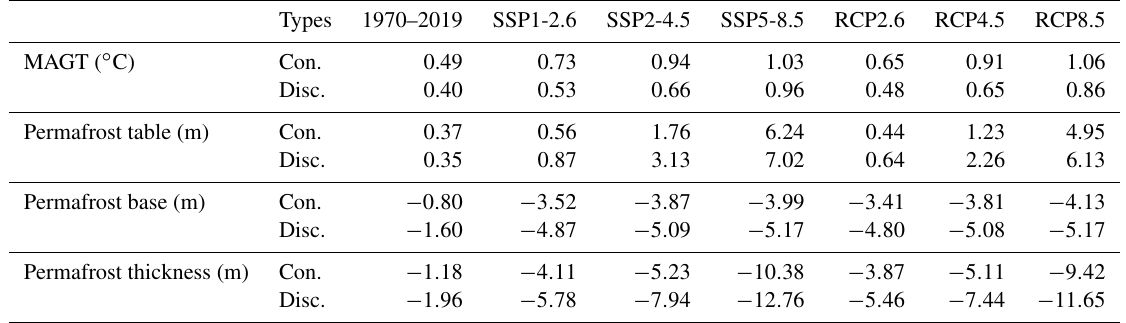
Table 3. Changes in characteristics of the frozen ground type over Xidatan for 1970 to 2019 and projected changes by the 2090s, relative to the 2010s, under different climate change